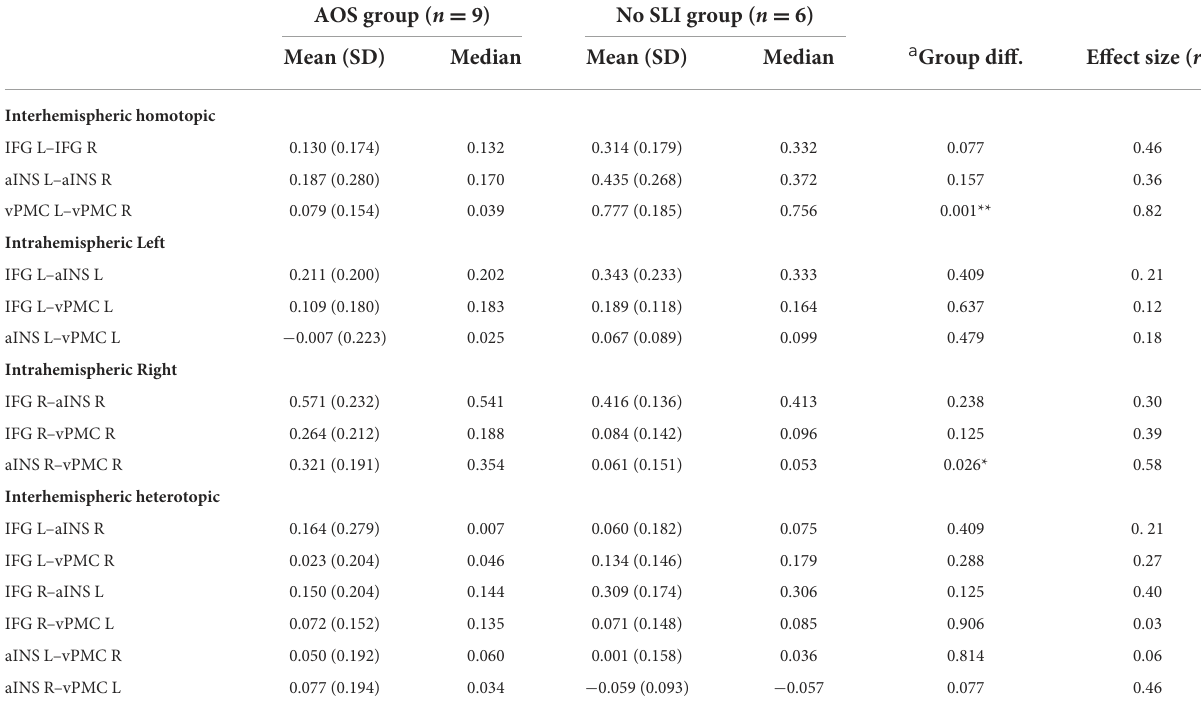
TABLE 6 Functional connectivity at A1, comparison between